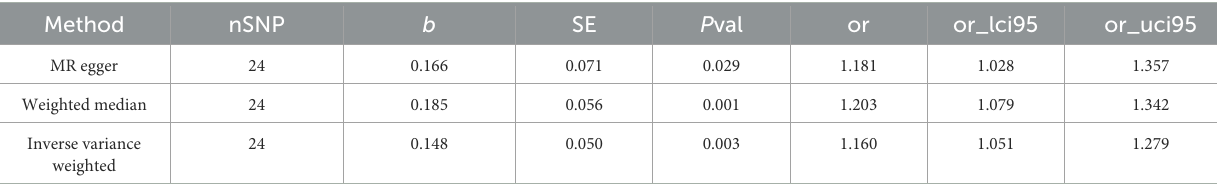
TABLE 2 MR analysis results between omega-3 fatty acids and generalized